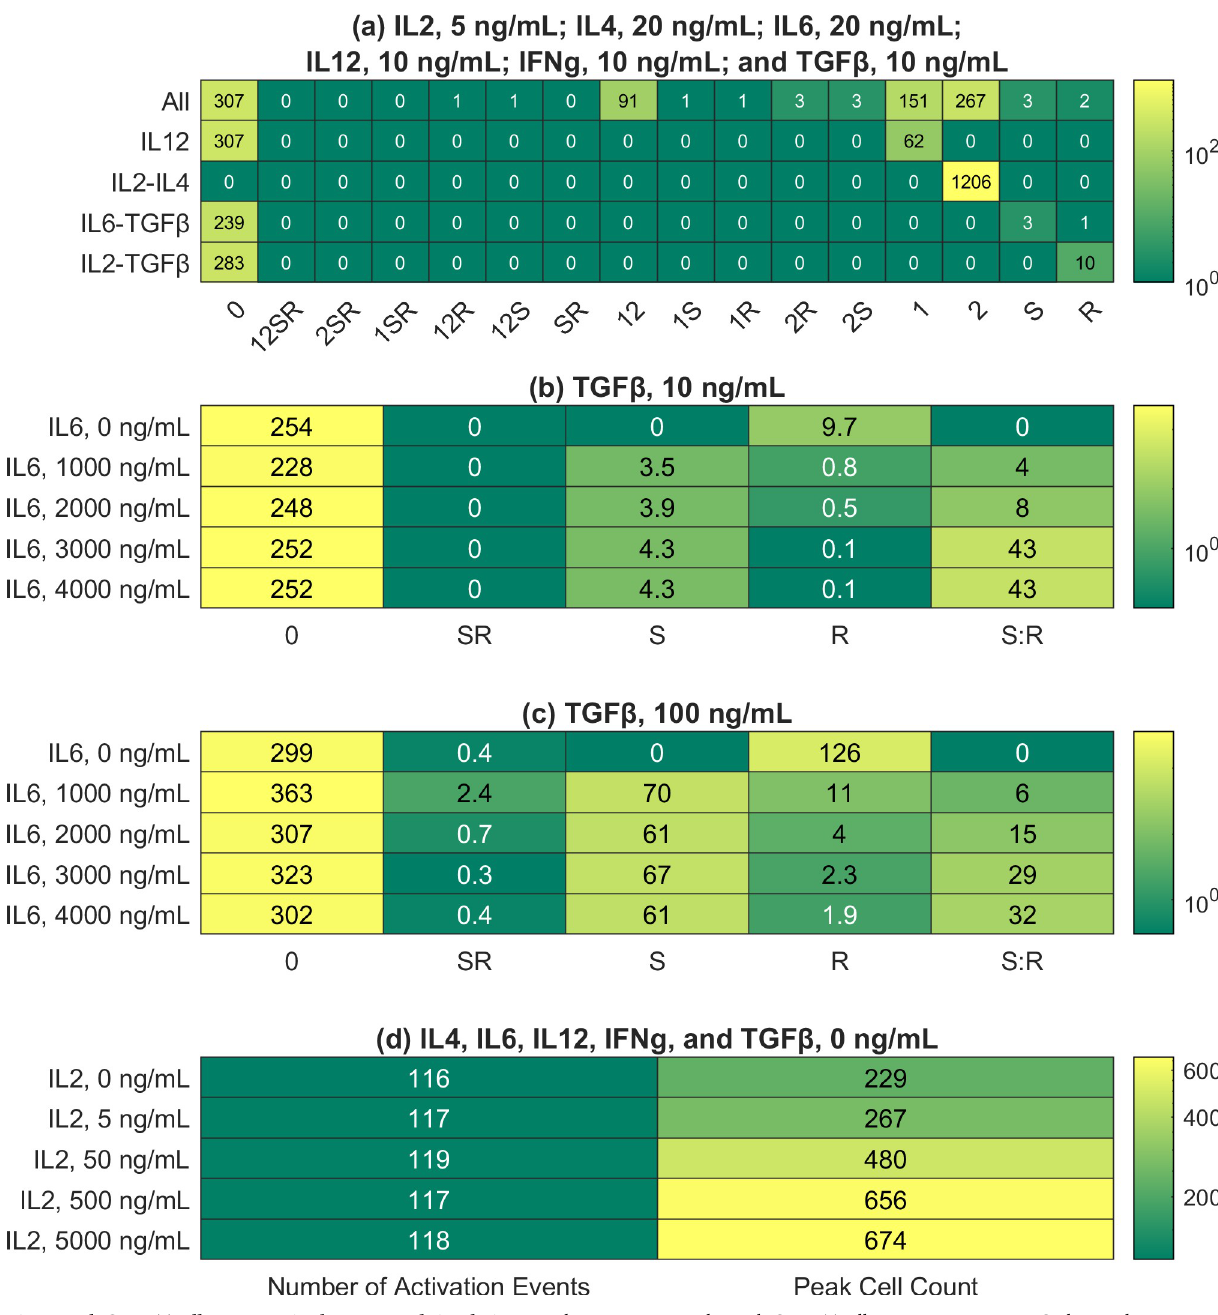
PLOS Computational Biology | https://doi.org/10.1371/journal.pcbi.1009209 August 3,